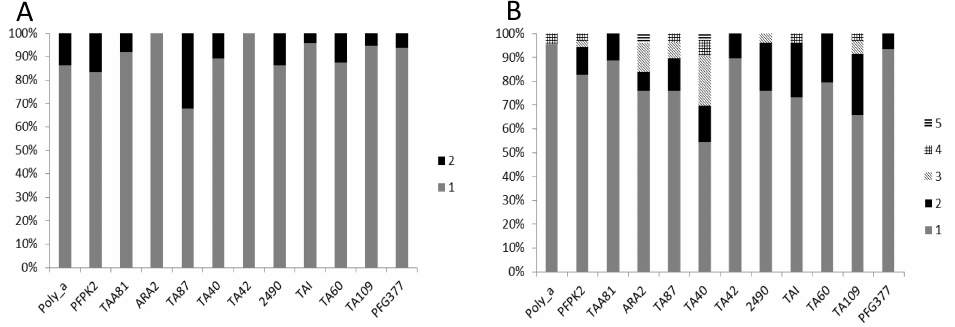
Figure 3. Distinct number of clones identified at each MS marker. ( A ), samples from Asutsuare and ( B ), samples from Obom. The color code representing the different number of clones for both graphs: gray (1), black (2), light gray polka dots (3), checkered (4) and black horizontal lines (5).